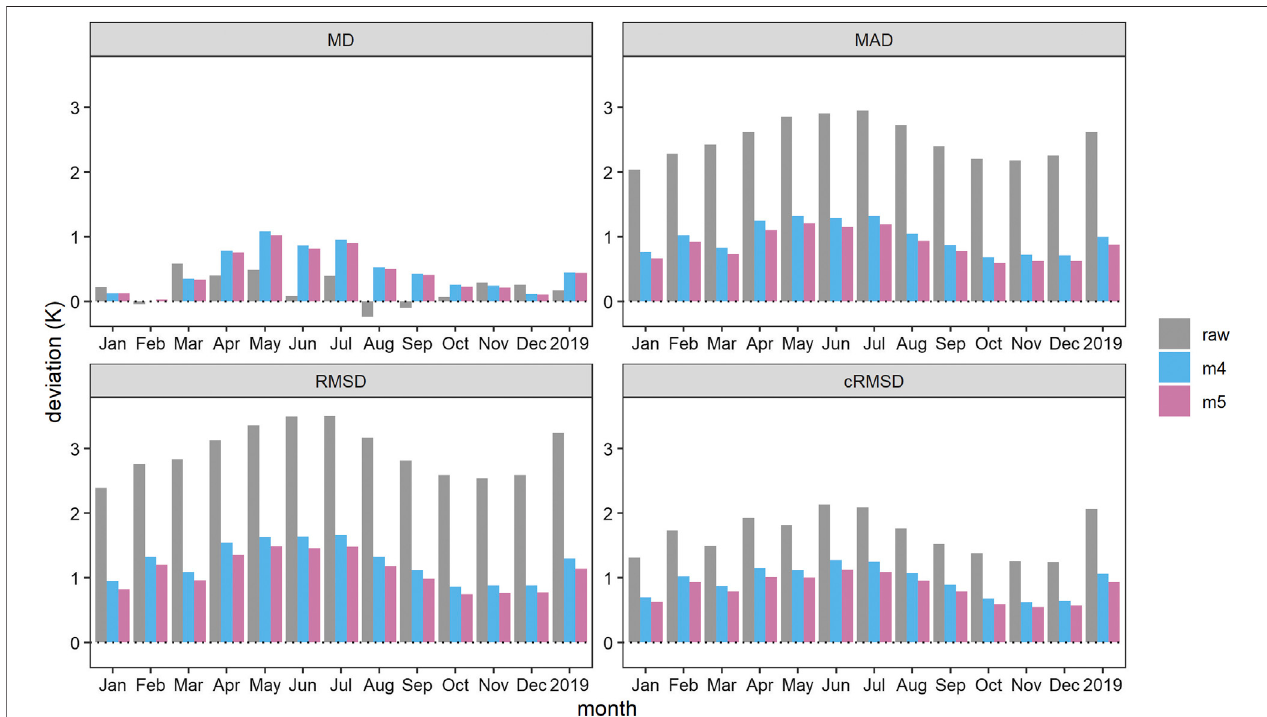
FIGURE8| Deviationsofhourlyairtemperature ( ta )betweenCWSandPRWSinAmsterdam during2019per monthandforthewholeyearforrawdata,QClevels m4, and m5. Deviations were calculated between each PRWS and each CWS within a radius of 2000 m around the respective PRWS, located in the same LCZ type as the PRWS. Deviations were then averaged per month and year across all CWS and PRWS. MD, mean deviation; MAD, mean absolute deviation; RMSD, root-mean- square deviation; cRMSD, centred